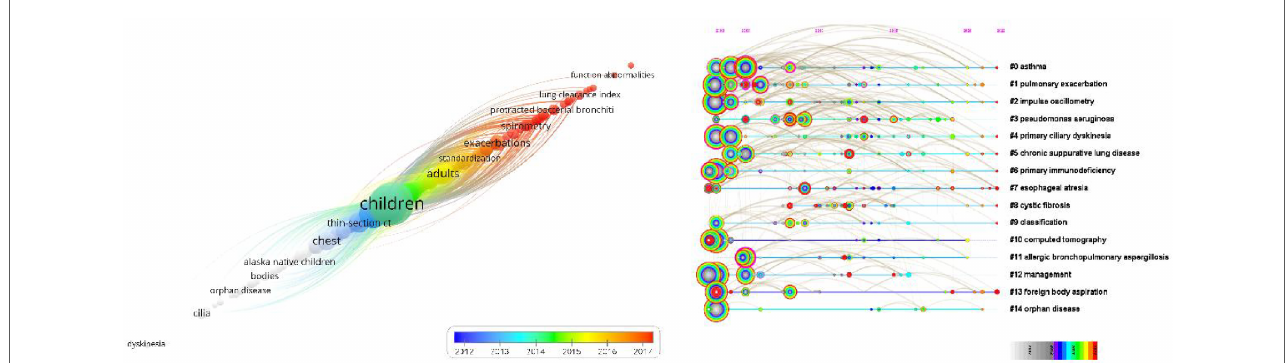
FIGURE 7 Analysis of keywords of bronchiectasis in children between 2003 and 2022. ( A ) Keyword evolution graph. Node size represents the frequency, and different color represents different years, as the label shows. ( B ) Timeline visualization of keywords. Nodes of the same cluster are arranged in the same row from left to right in chronological order. Nodes with purple outer rings are burst